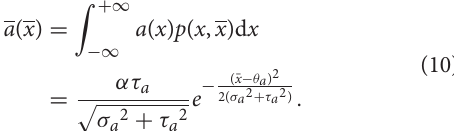
0.2) prevents collapse ( Figure 3 ) but resource abundances fall so low that extinction = 0.5) and the handling time is sufficiently short [ h 0.05; (C,H) ], minimum resource abundance = =